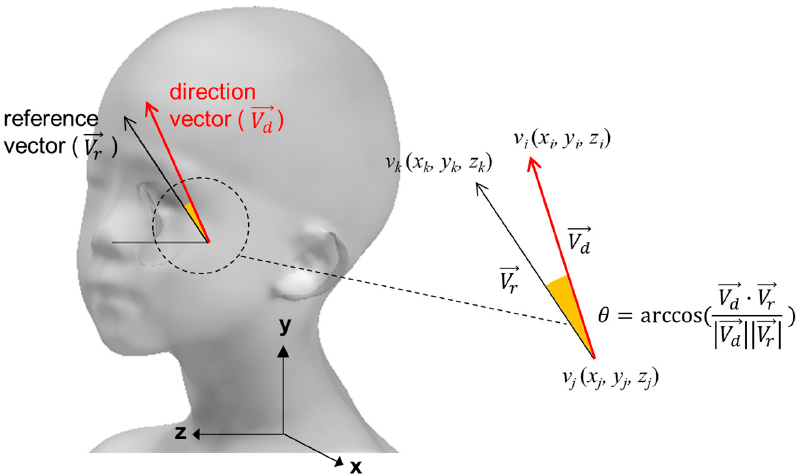
Figure 7. The 3D angle between reference vector and direction vector.